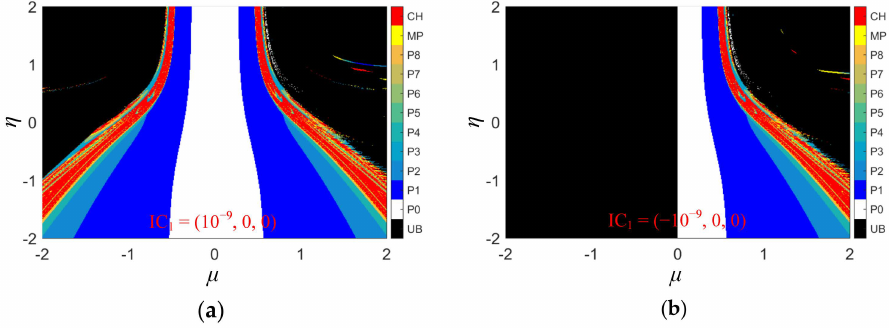
Figure 6. Local basins of attraction in the µ – η plane for two sets of tiny non-memristor initial conditions IC 1 = ( x 1 (0), x 2 (0), x 3 (0)): ( a ) IC 1 = (10 − 9 , 0, 0), and ( b ) IC 1 = ( − 10 − 9 , 0, 0).